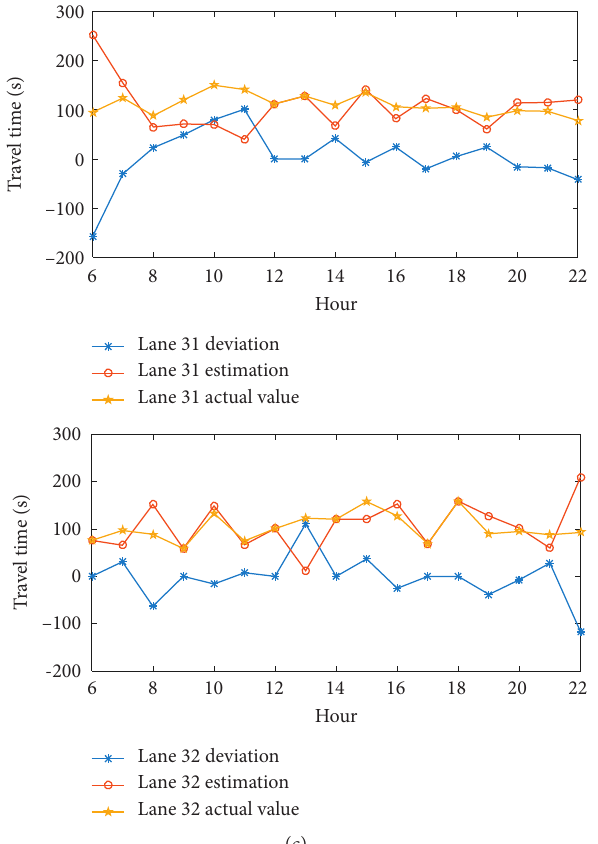
Figure 11: Data fitting accuracy at each lane condition: (a) lanes and lane 1 upstream conditions, (b) lane 2 upstream conditions, and (c) lane 3 upstream